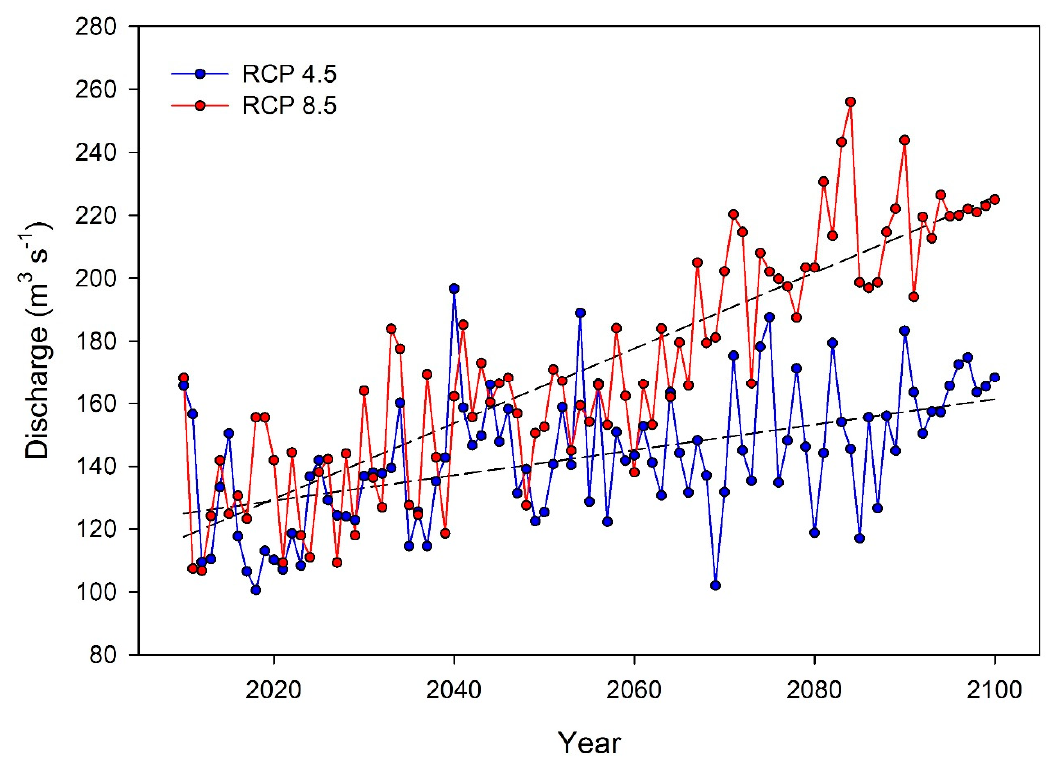
Figure 11. The trend of yearly projected average discharge under RCP4.5 and RCP8.5 climate change scenarios for the Astore River at the Doiyan gauge station.